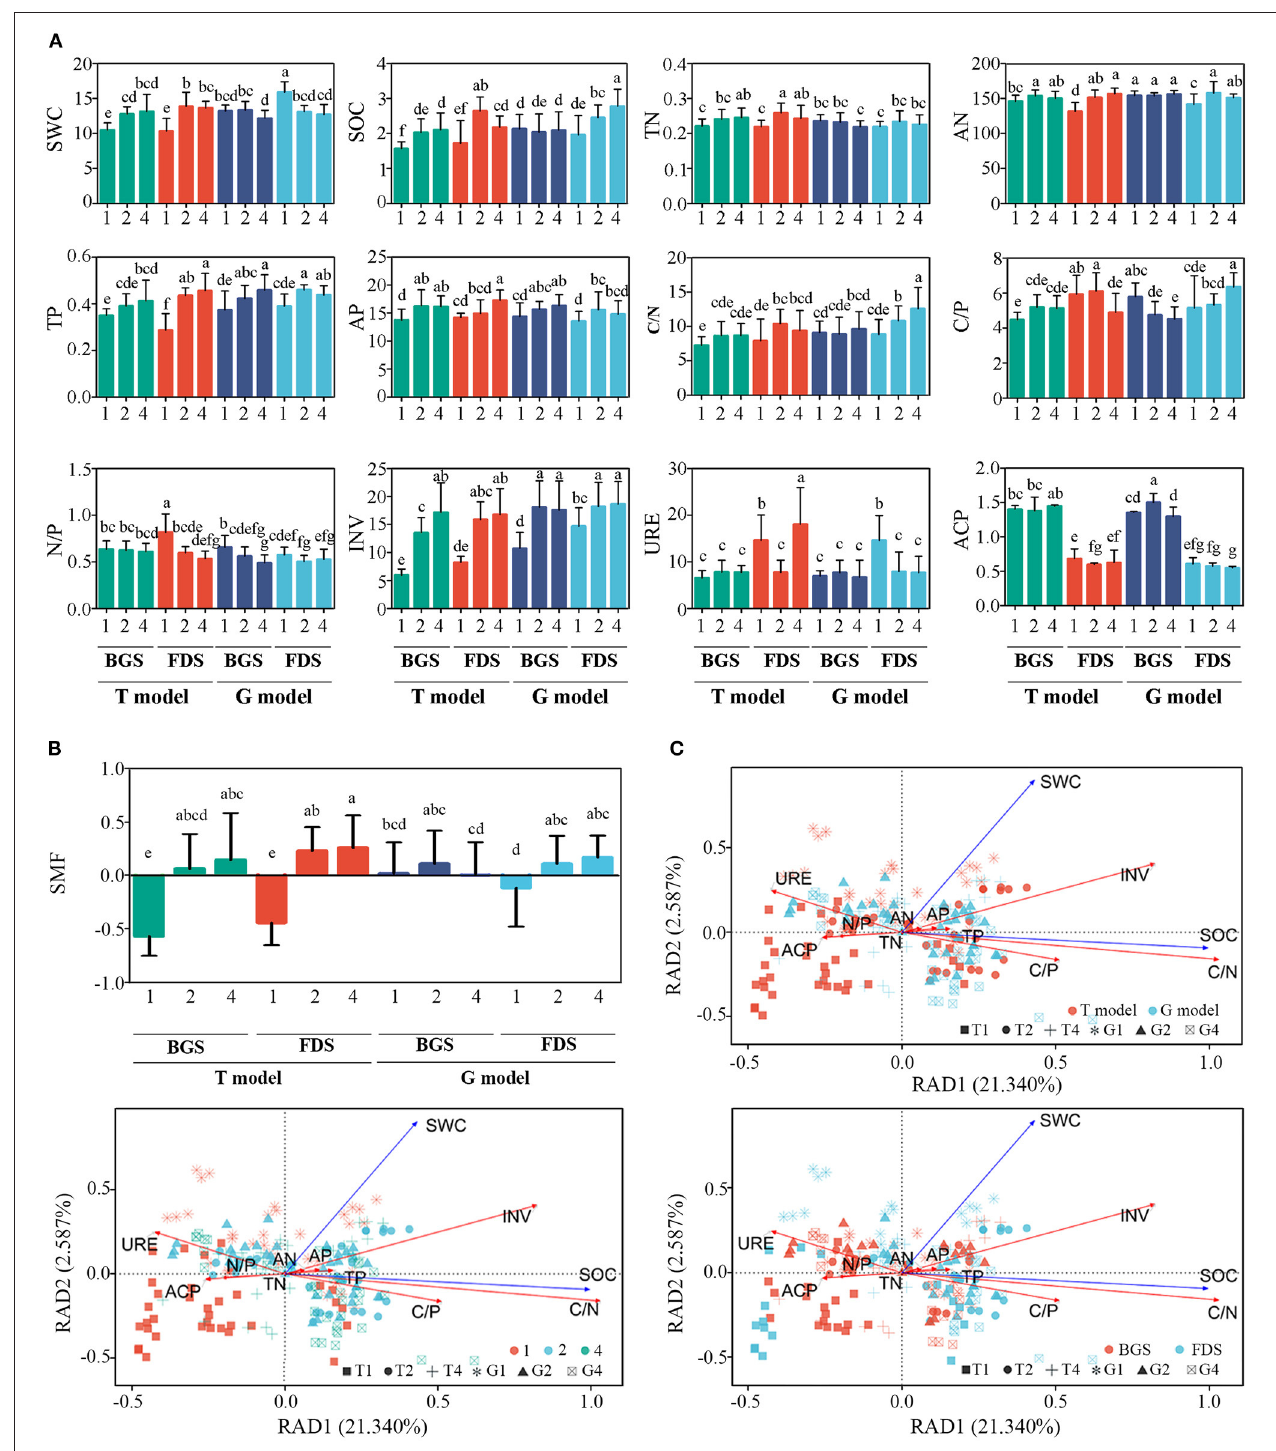
FIGURE 6 | Variation in soil properties, SMF index and redundancy analysis (RDA) of soil nutrient variables between the intercropping patterns and between the development stages in the studied soils. (A) Variation in soil properties. (B) SMF, soil ecosystem multifunctionality. (C) RDA constrained by basic physico-chemical parameters. SWC, soil water content; SOC, total soil organic C content; TN, total nitrogen (g kg − 1 ); TP, total phosphorus (g kg − 1 ); AN, available nitrogen (mg kg − 1 ); AP, available phosphorus (g kg − 1 ); C/N, ratio between SOC and TN; C/P, ratio between SOC and TP; N/P, ratio between TN and TP; URE, urease activity (mg NH4 + -N g − 1 soil 24 h − 1 ); INV, invertase activity (mg glucose g − 1 soil h − 1 ); ACP, acid phosphatase activity (g − 1 h − 1 ). 1, 2, and 4 indicate intercropping with 0, 1, and 3 species of aromatic plants, respectively, to facilitate regression analysis. BGS, branch growth stage; FDS, fruit development stage. T model, intercropping with aromatic plants in the clean tillage soil; G model, intercropping with aromatic plants in the natural grass soil. Different letters indicate significant differences at P < 0.05 based on Duncan’s multiple range